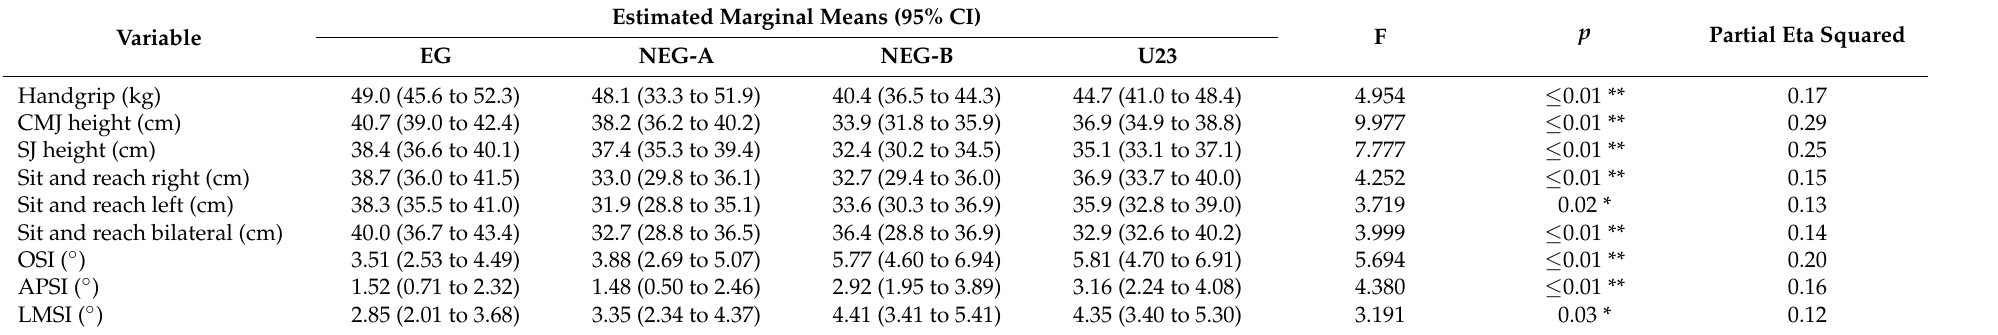
Table 2. Results of the one-way between-group analysis of covariance for physical development tests after adjusting for